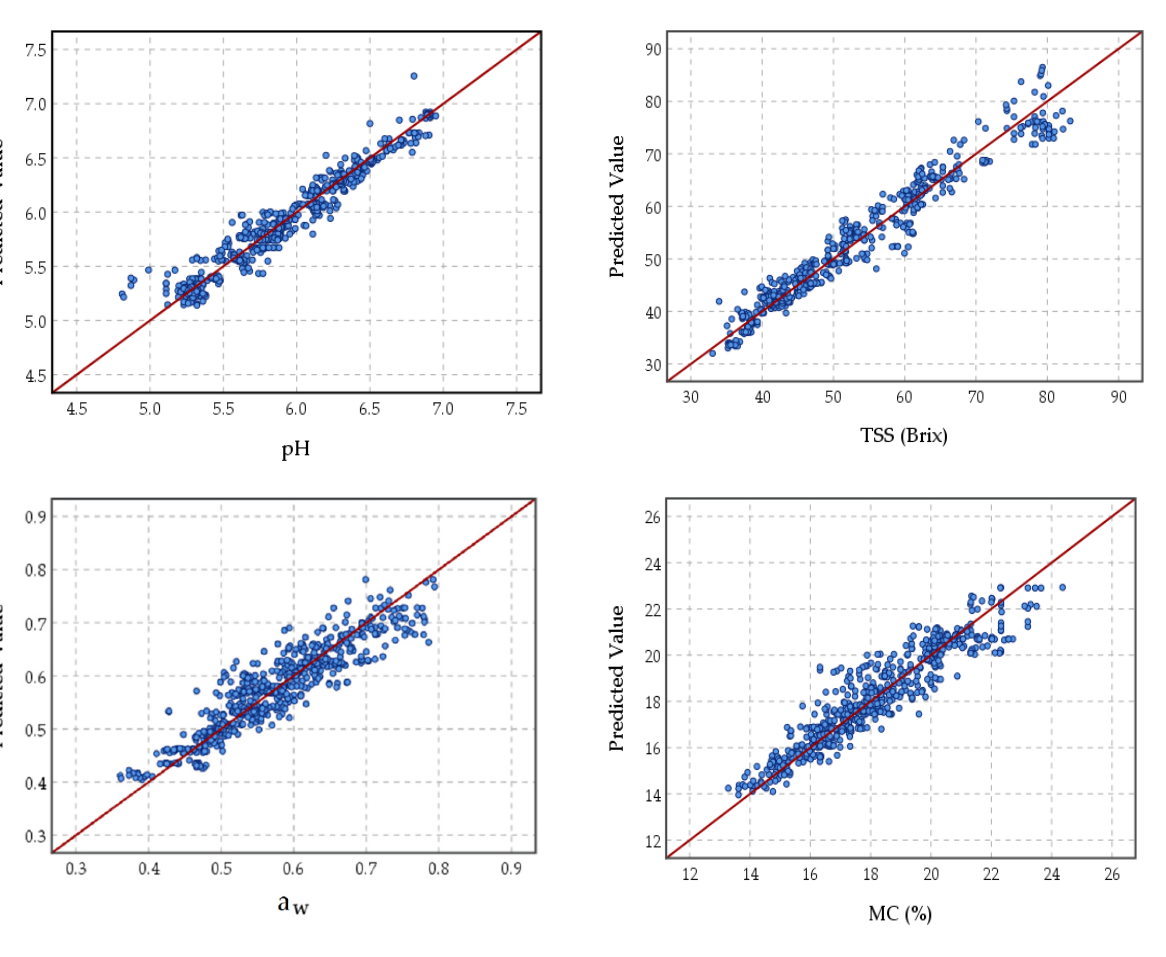
Figure 7. Scatter plots of measured values of pH, total soluble solids (TSS), water activity (a w ), and moisture content (MC) versus the predicted values by the neural networks model in the evaluation phase based on the measured electrical properties of the stored date fruits at 10,000 Hz.